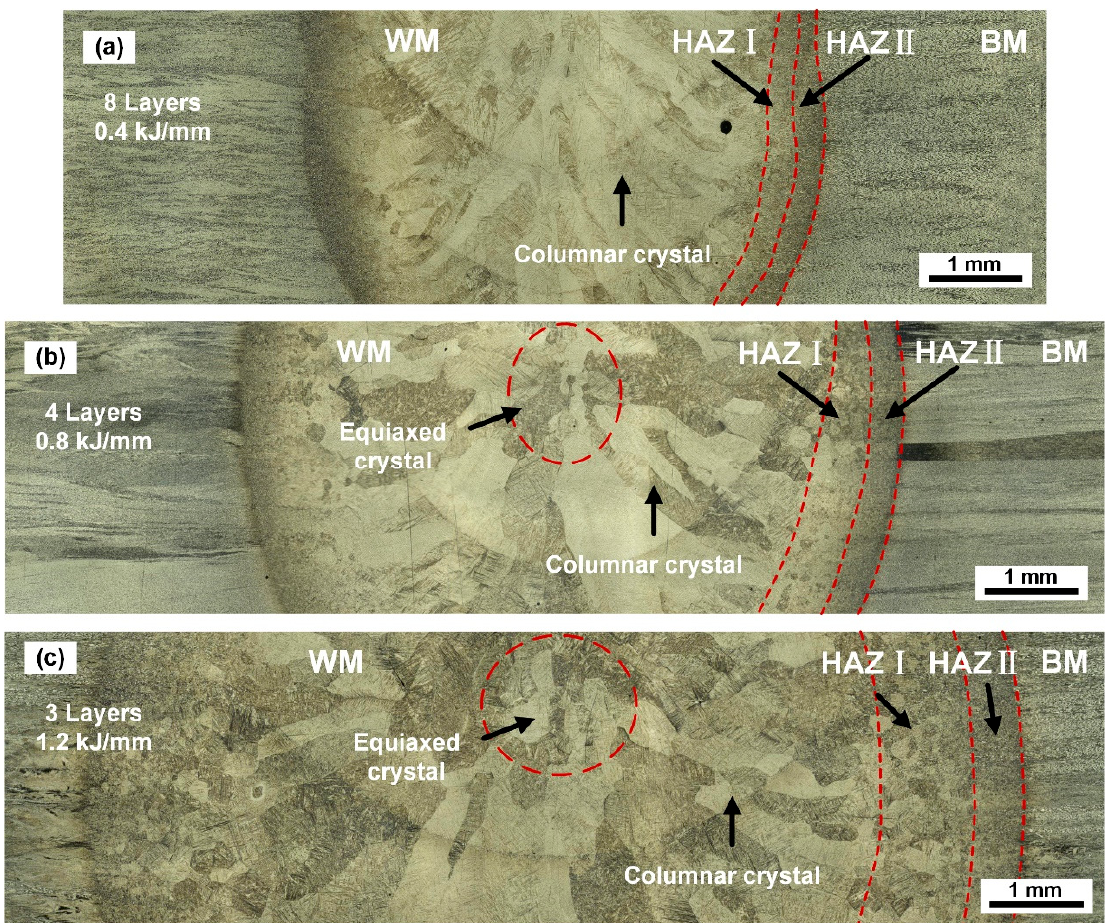
Figure 5. The microstructure of the weld with different filling layers and line energy. ( a ) A total of 8 layers with 0.4 kJ/mm; ( b ) 4 layers with 0.8 kJ/mm; ( c ) 3 layers with 1.2 kJ/mm.